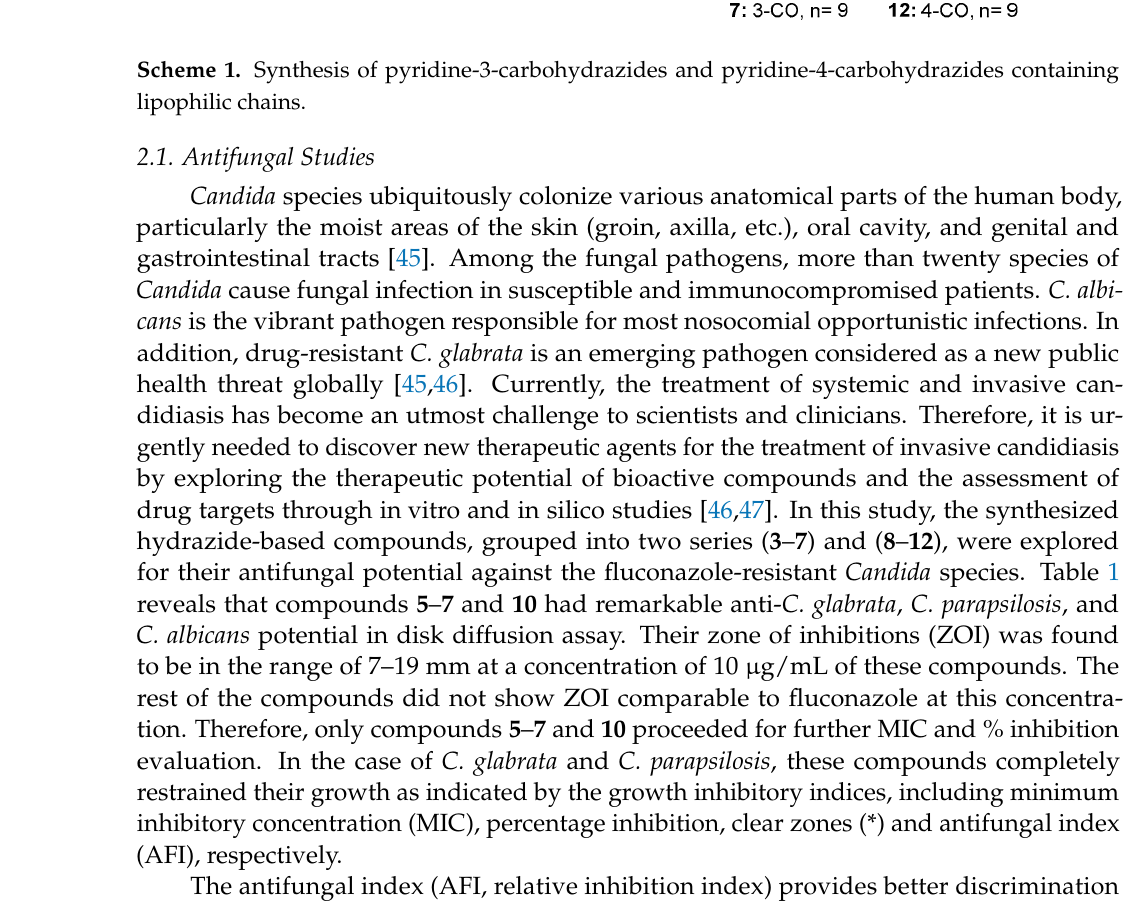
Table 1. In vitro antifungal activity of synthetic compounds against fluconazole resistant Candida